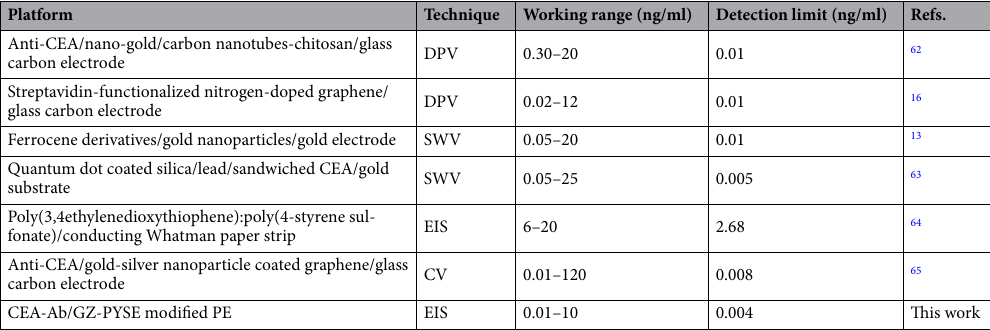
Table 2. Analytical performance of the fabricated CEA immunosensor against other reported CEA sensors.